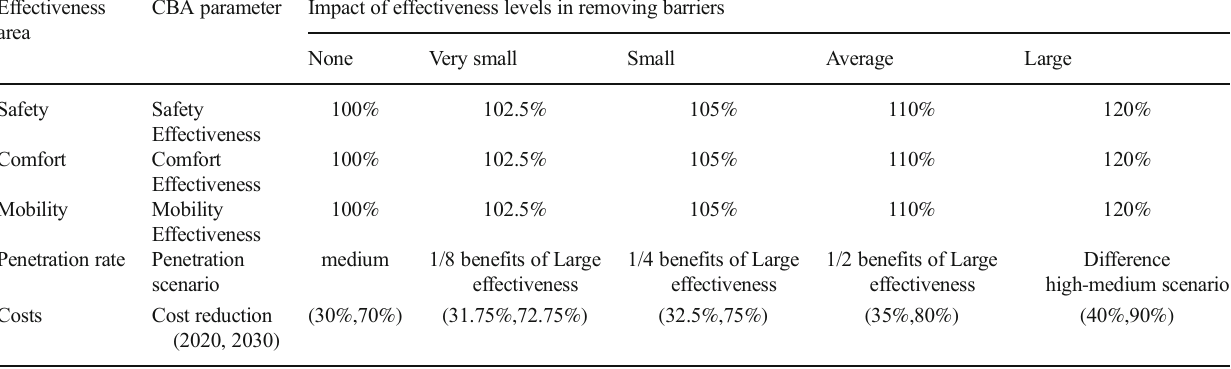
Parameters of assumed effectiveness of recommendations Effectiveness area